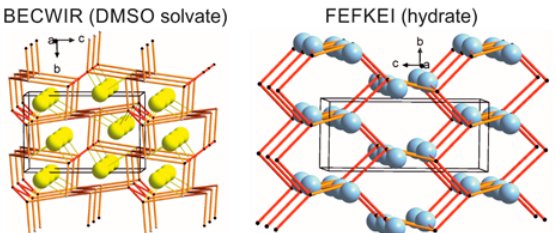
Figure 14. Simplified hydrogen-bonded networks showing LSAMs in perindoprilat crystals. The black and gray dots represent a center of gravity of the molecules, orange-shaded lines stand for O-H ... O or N-H ... O hydrogen bonds. Blue and yellow spheres represent the positions of water or DMSO molecules, respectively.